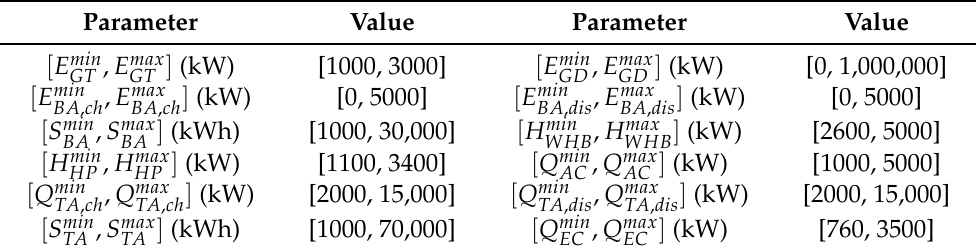
Table 1. Values of system parameters for